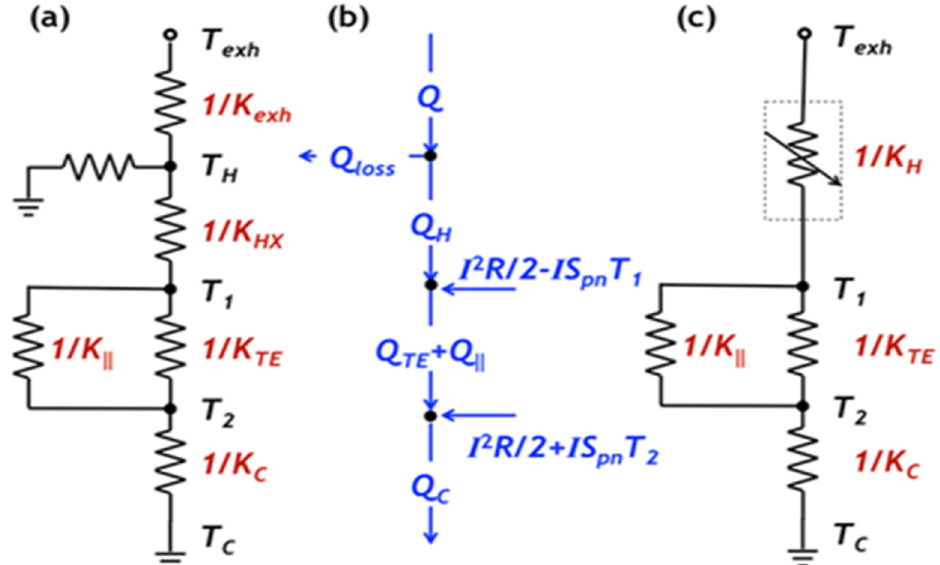
Figure 18. ( a ) Thermal resistance network for exhaust heat recovery including leakage from the hot-side heat exchanger. ( b ) General heat and electrical energy flows. ( c ) Different representation of circuit ( a ) with resistances added to achieve variable 1/K H resistance representation.